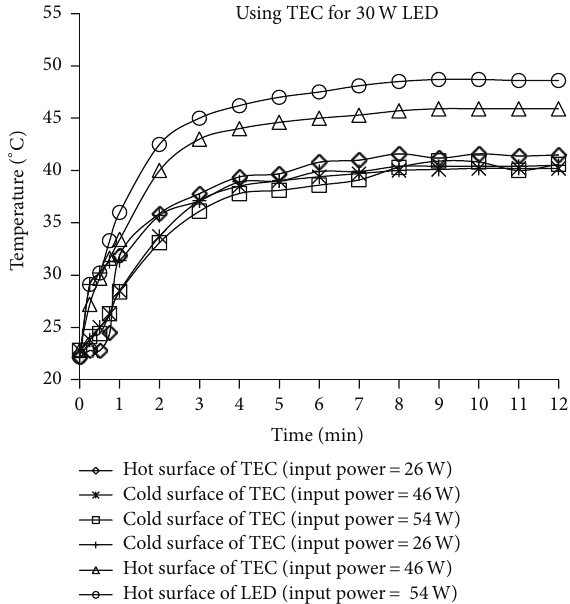
Figure 9: The cold and hot surface temperature values of the TEC element during the cooling process of the LEDs with the 30 W LED configuration via cooling systems in which the TEC elements were